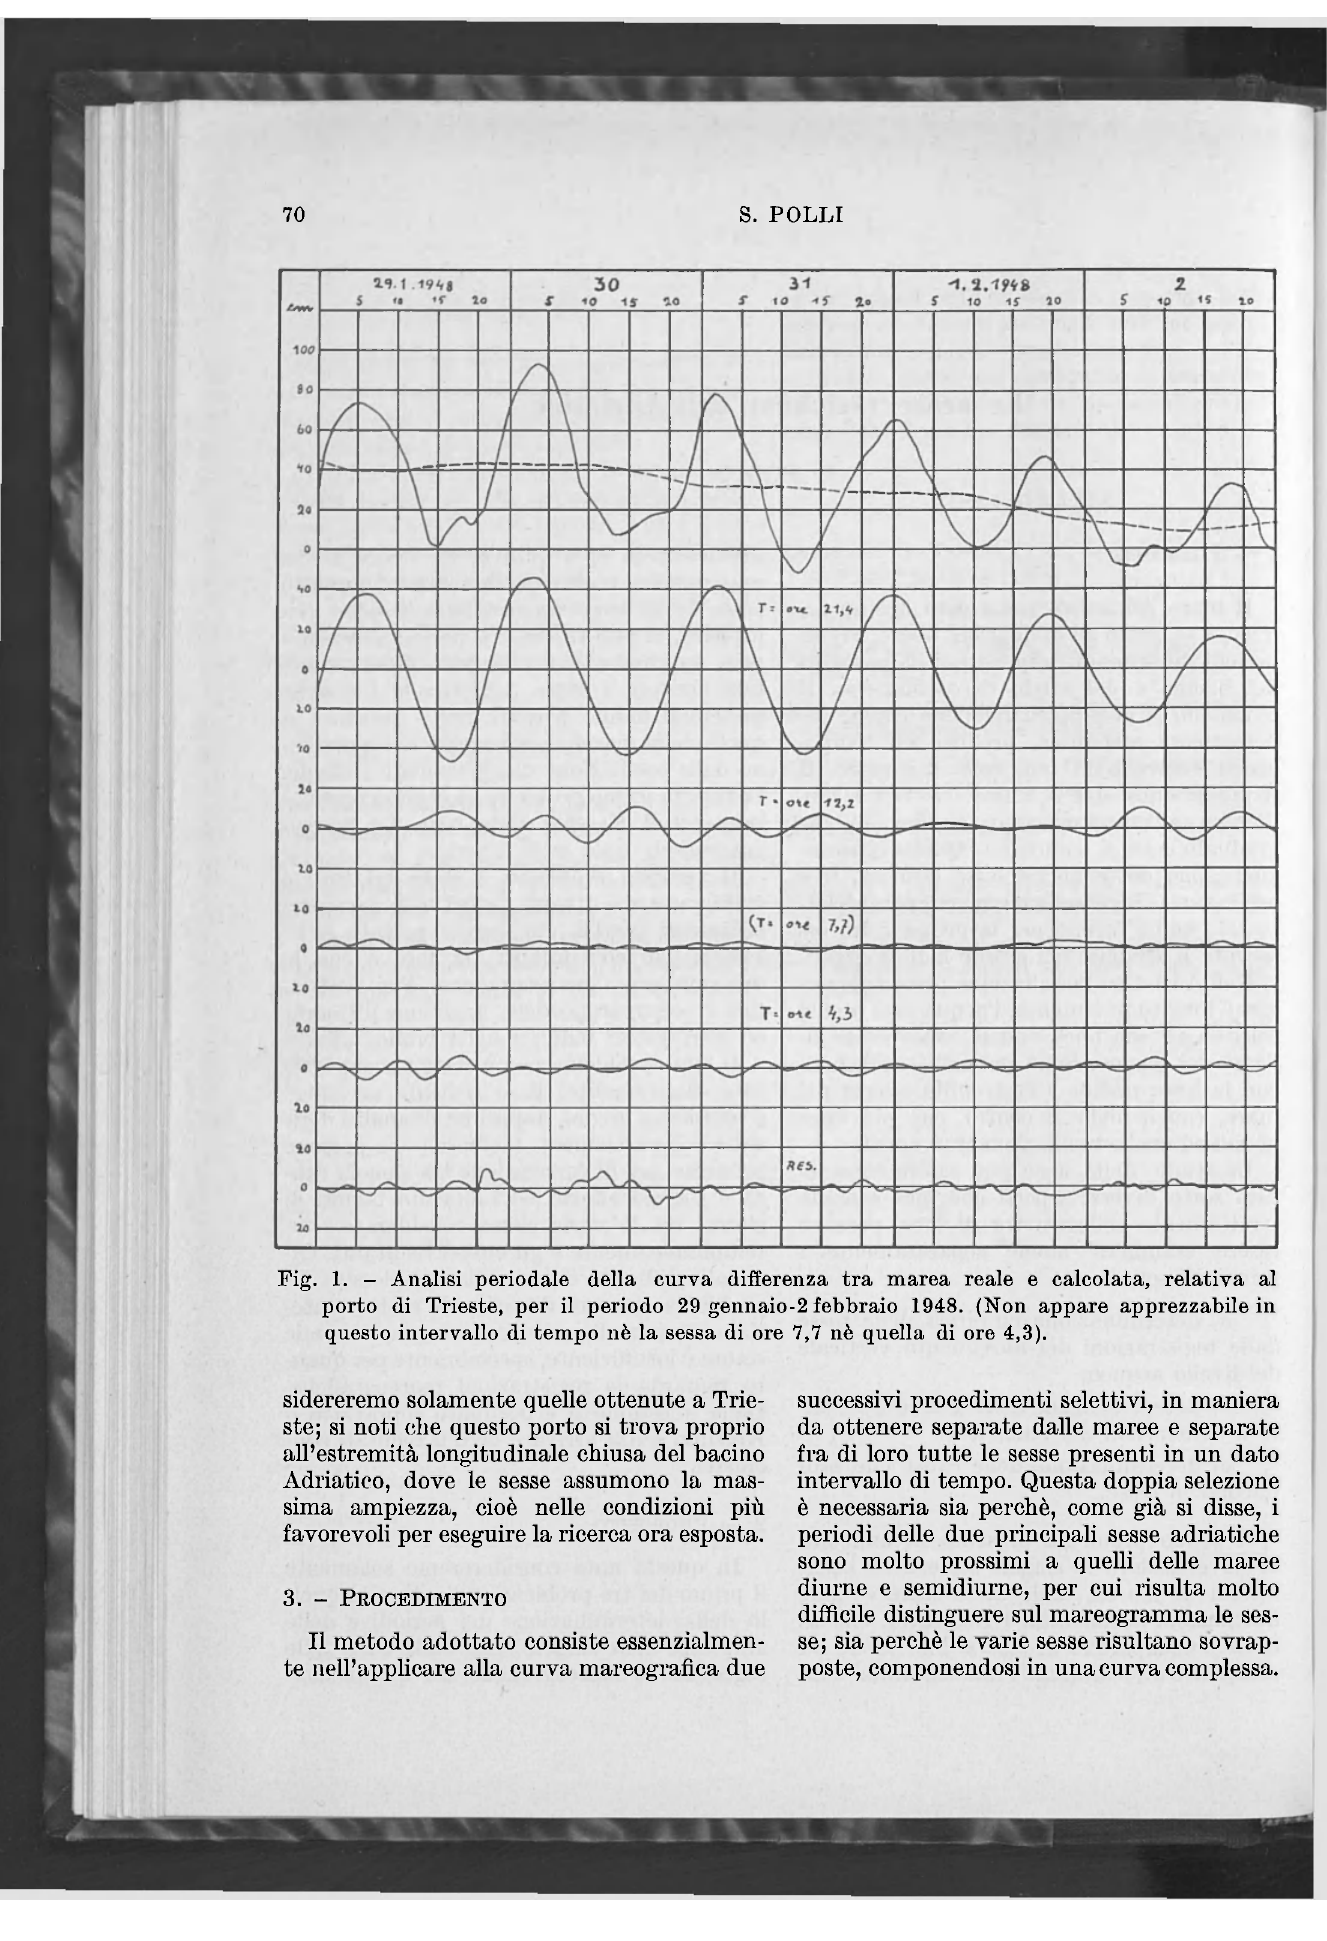
Fig. 1. - Analisi periodale della curva differenza tra marea reale e calcolata, relativa al porto di Trieste, per il periodo 29 gennaio-2 febbraio 1948. (Non appare apprezzabile in questo intervallo di tempo uè la sessa di ore 7,7 nè quella di ore 4,3). sidereremo solamente quelle ottenute a Trie- ste; si noti che questo porto si trova proprio all'estremità longitudinale chiusa del